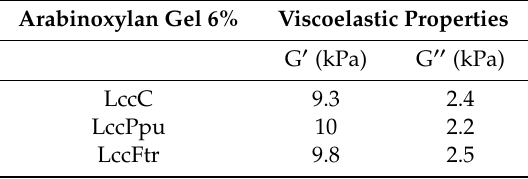
Table 1. Viscoelastic properties of the 6% arabinoxylan gels formed with di ff erent laccases.